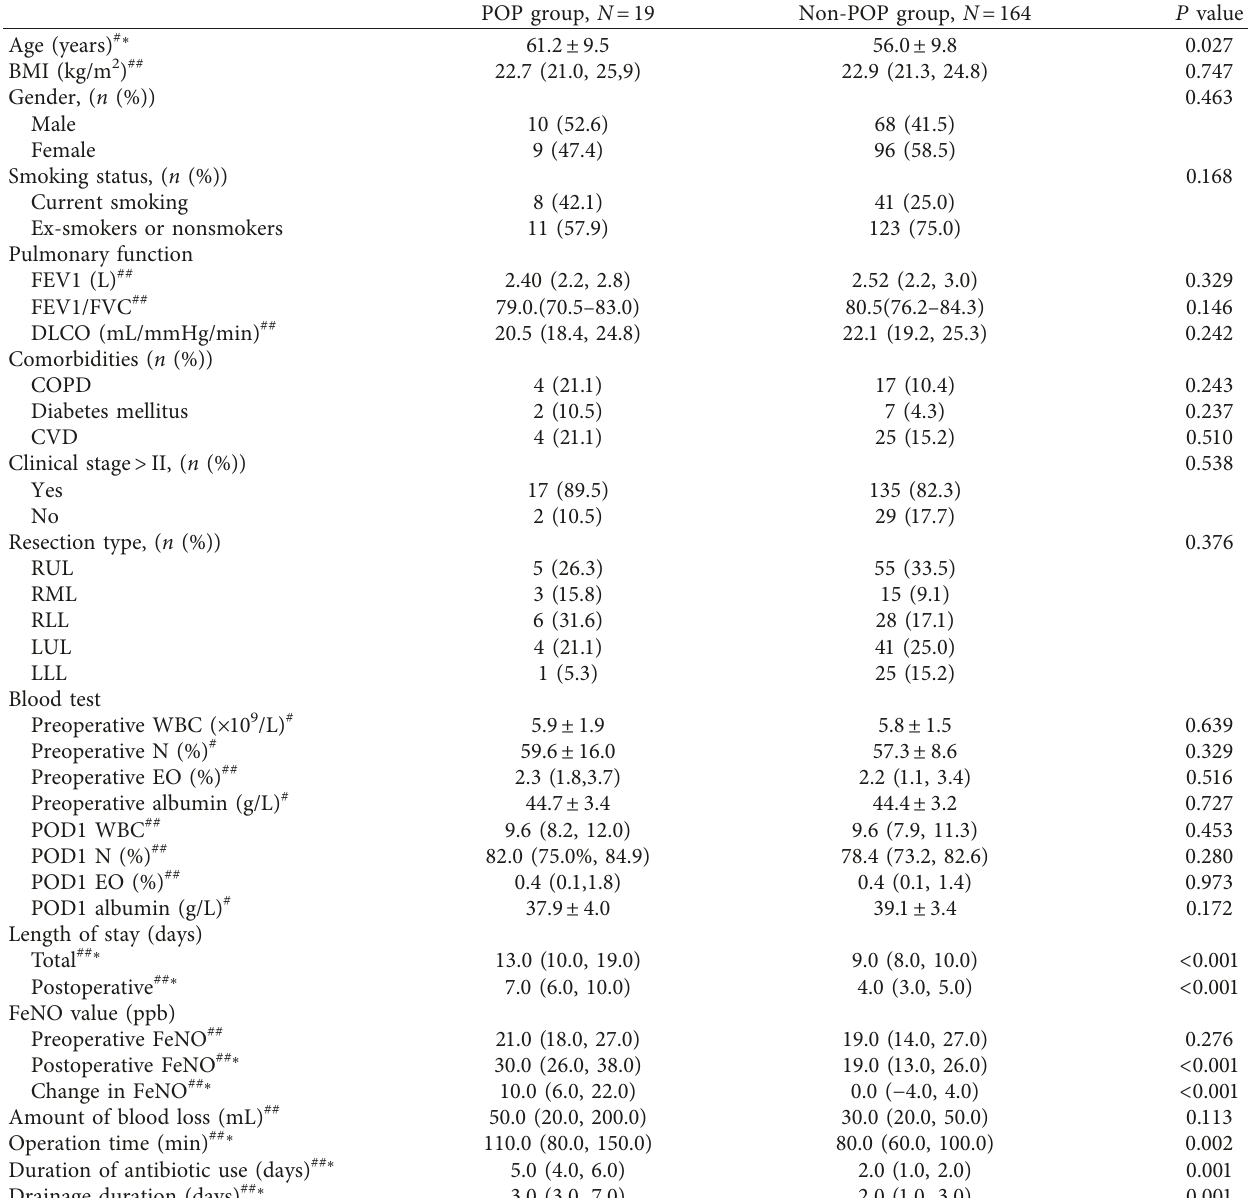
Table 1: Baseline and clinical characteristics of the two